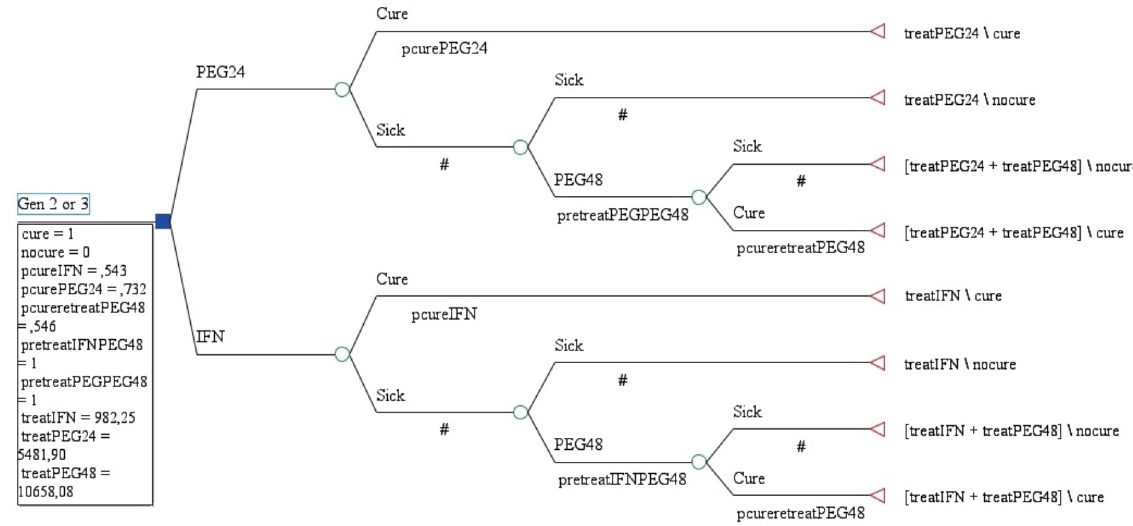
FIGURE 1 - Cost effectiveness analysis comparing PEG-SEC with PEG-FIRST24.